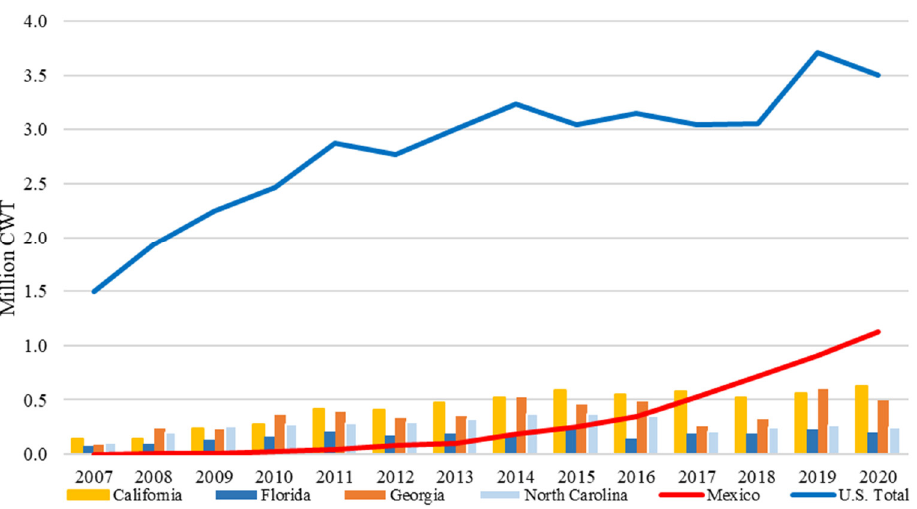
Figure 8. U.S. production and Mexican imports: fresh blueberry. Notes: The fresh blueberry production data of California from 2013 to 2017, Florida from 2016 to 2020, and North Carolina from 2018 to 2020 are undisclosed and calculated based on the percentages of fresh blueberries from available data; on average, 92% of California, 95% of Florida, and 75% of North Carolina total production were sold to the fresh market. Sources: USDA FAS [11] ; USDA NASS [37] .